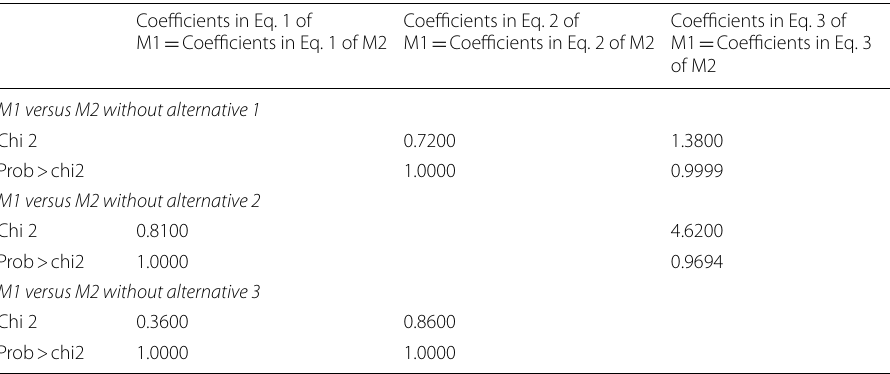
Table 8 Results of McFadden-Hausman IIA test / East African Countries’ sample. Source : Author’s